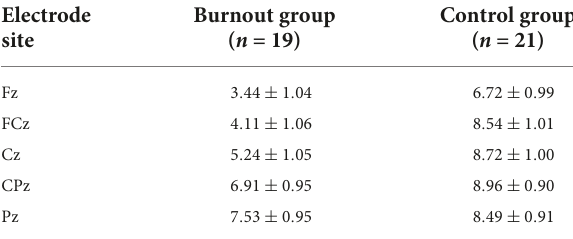
TABLE 5 Description of the average P3b amplitude in the burnout and control groups ( ¯ x ± SE, µ